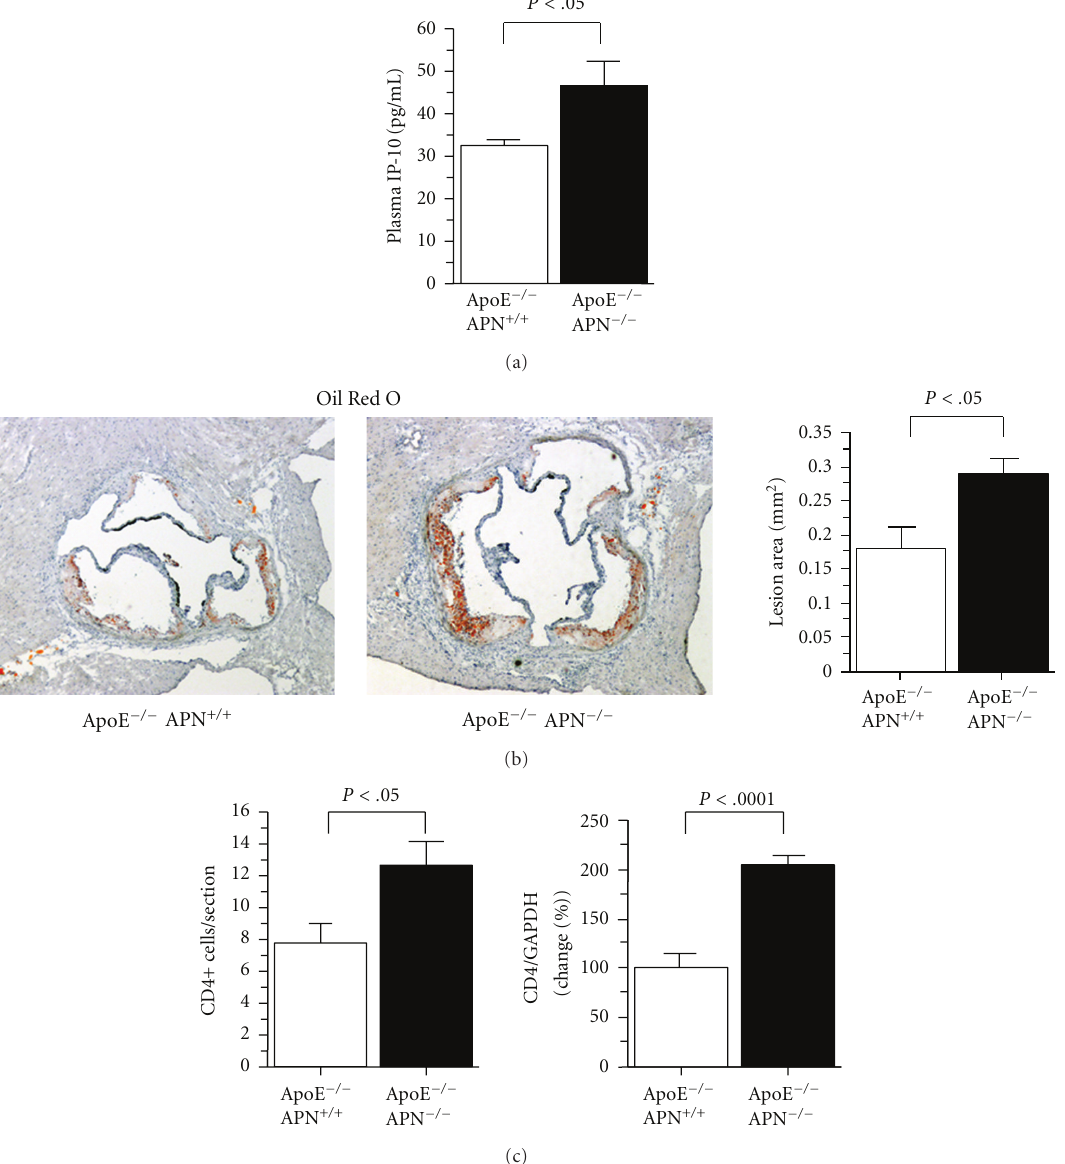
Figure 1: APN deficiency in apoE knockout mice. Compared with apoE single knockout mice, APN/apoE double knockout mice showed (a) higher plasma IP-10 levels, (b) advanced atherosclerosis, and (c) accelerated accumulation of T lymphocytes in atherosclerotic lesions (Adapted from